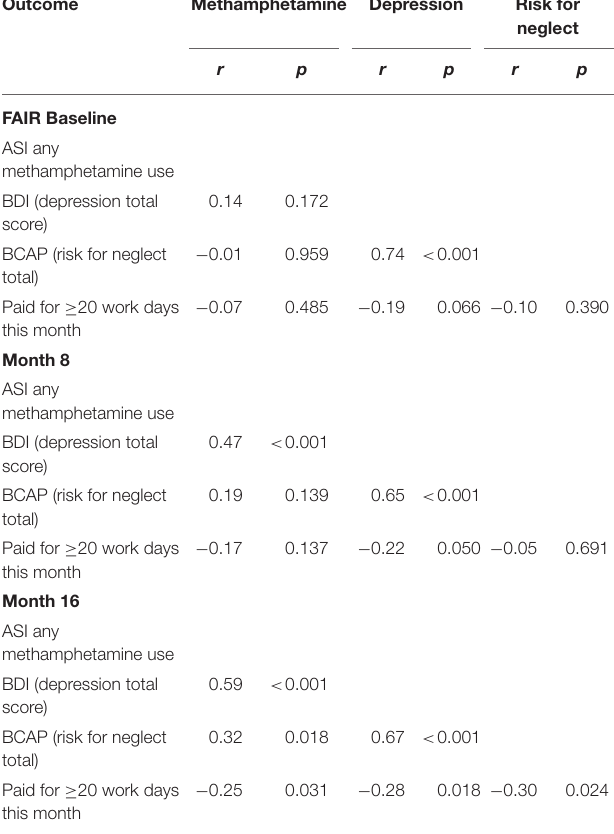
TABLE 3 | Correlations between select outcomes from the substance abuse, mental health, parenting risk, and parent stability domains at FAIR baseline, Month 8, and Month 16.